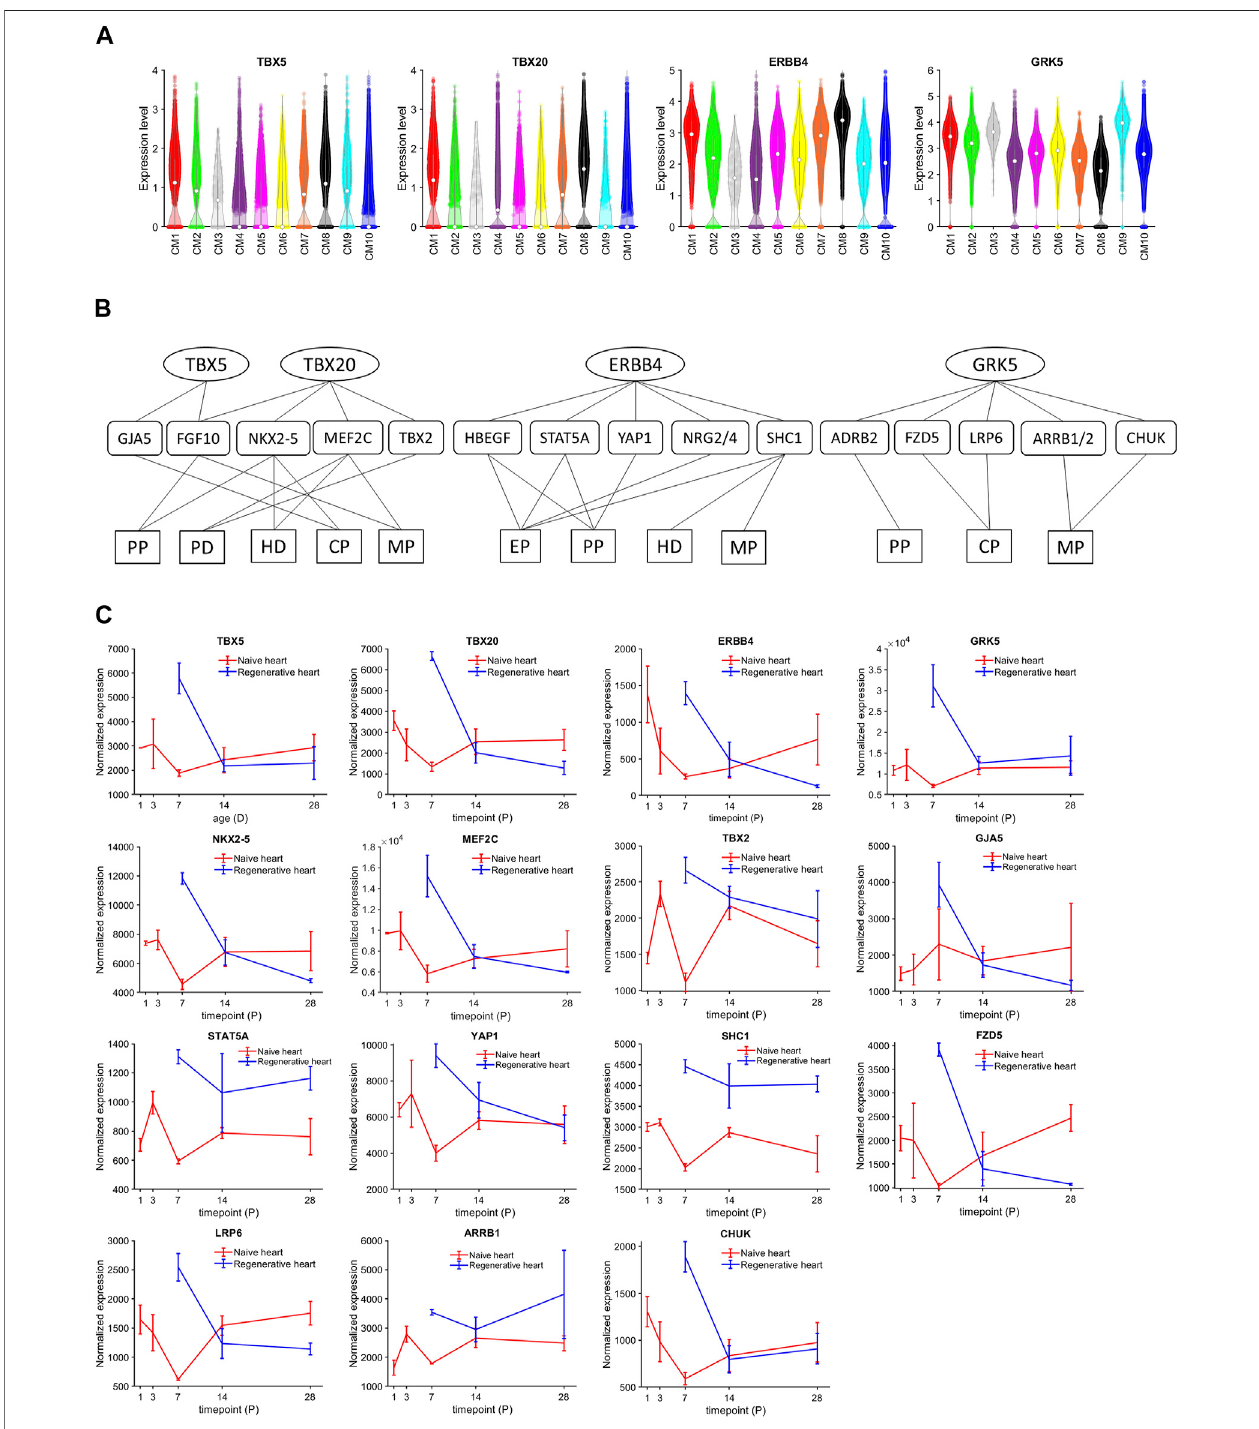
FIGURE 3 | TBX5, TBX20, ERBB4, and GRK5 were consistently upregulated in CM1, CM7, and CM8 cardiomyocytes. (A) The abundance of TBX5, TBX20, ERBB4, and GRK5 RNA transcripts was measured in cardiomyocytes from each cluster and displayed in a violin plot. The expression was normalized according to the Seurat pipeline: the expression matrix was scaled by the ScaleData function with vars. to. regress set to nUMI and nGenes; then, the scaled expression was log- normalized. (B) The network of genes, cellular processes, and signaling pathways regulated by TBX5, TBX20, ERBB4, and GRK5 was evaluated with DAVID bioinformatics resources. Targeted genes were identi fi ed in the TRRUST v2 (TBX5 and TBX20) and STRING v11.5 (ERBB4 and GRK5) databases and functional/ pathway data were obtained from the GOA, KEGG, and Reactome databases. PP, positive regulation of cell proliferation; PD, positive regulation of cardiac muscle cell differentiation; CP, canonical Wnt signaling pathway; MP, MAPK signaling pathway; Ep, ErbB signaling pathway. (C) The bulk RNAseq expressions of TBX5, TBX20, ERBB4,GRK5,NKX2-5,MEF2C,TBX2,GJA5,STAT5A,YAP1,SHC1,FZD5,LRP5,ARRB1,andCHUKinregenerativeandnaïvepigheart.Thetranscriptcountswere normalized using DeSeq2